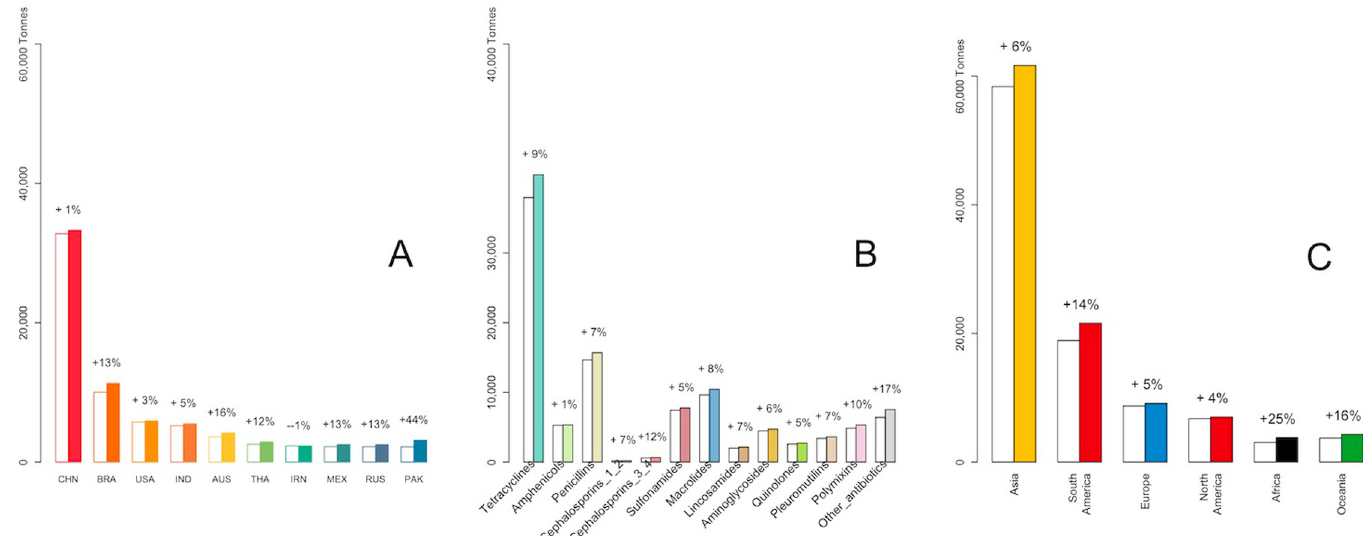
Fig 1. Veterinary antimicrobial consumption in 2020 (white bars) and their projected consumption for 2030 (coloured bars) by (A) country (top 10), (B) antimicrobial class, and (C) continent. CHN, China; BRA, Brazil; IND, India; USA, United States; AUS, Australia; IRN, Iran; THA, Thailand; PAK, Pakistan; JPN, Japan; MEX, Mexico.